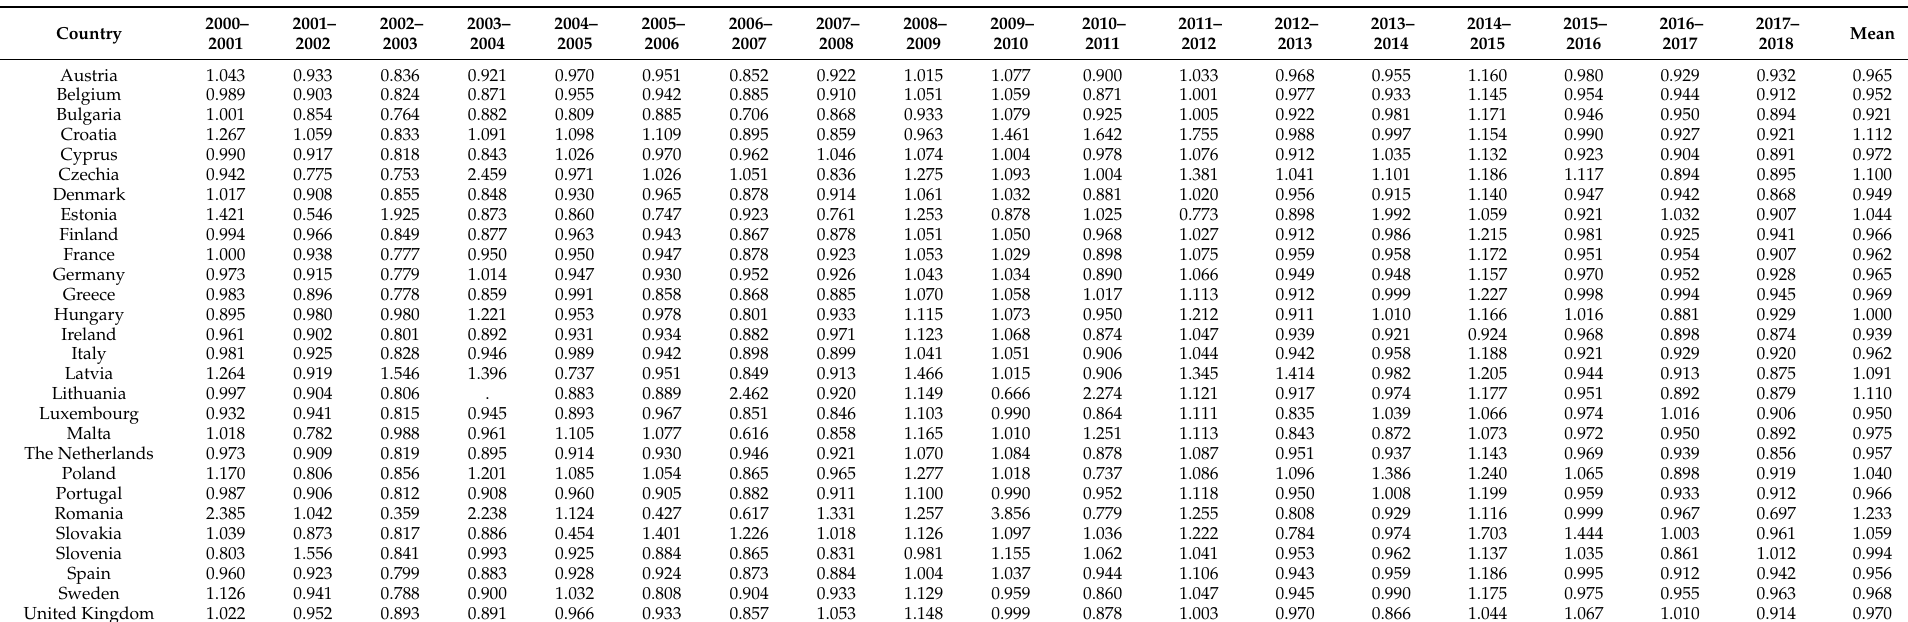
Table 4. Malmquist productivity indices.